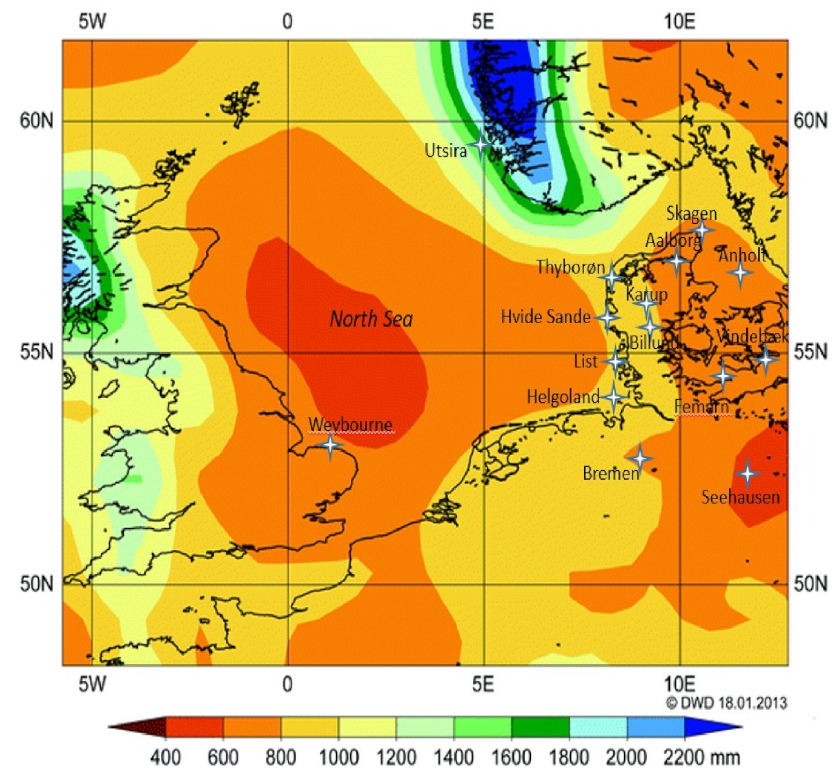
Figure 2. Mean annual precipitation totals derived from satellite data showing the spatial distribution of precipitation (mm) across the North Sea region derived from the combined HOAPS-3 and GPCC data set for the period 1988–2008 (figure prepared by the German Meteorological Service,